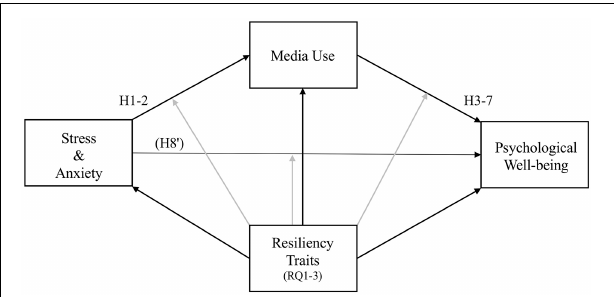
FIGURE 1 | Conceptual model. Stress and anxiety are tested as two distinct independent variables. H3-7 predict different forms of media use (media exposure, using media to cope, hedonic media use, eudaimonic media use, and intrinsically satisfying media use) will be associated with three well-being measures (affect, mental health, and flourishing). H8 predicts media use will mediate the relationship between stress/anxiety and well-being. RQ1-3 examine the main effects and potential moderation role of resiliency trait factors hope, optimism, and